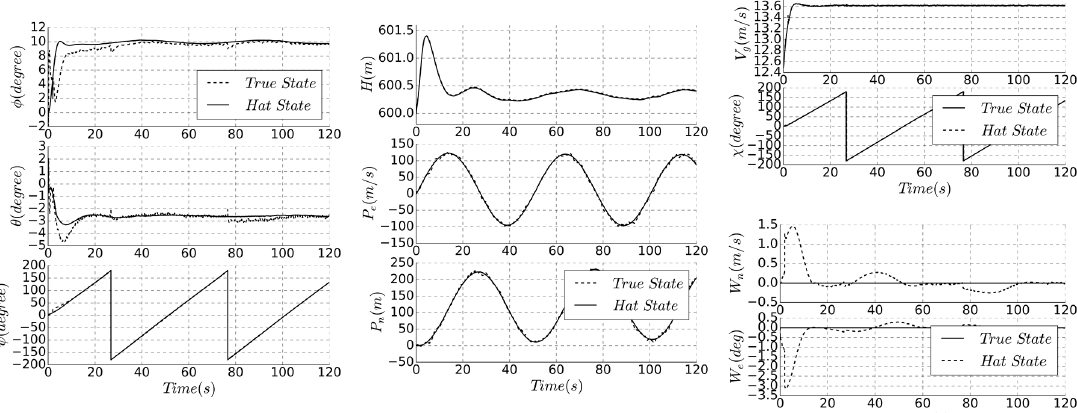
Figure 9. Comparison of true and estimated state. Algorithm 2. Full-state direct state estimation